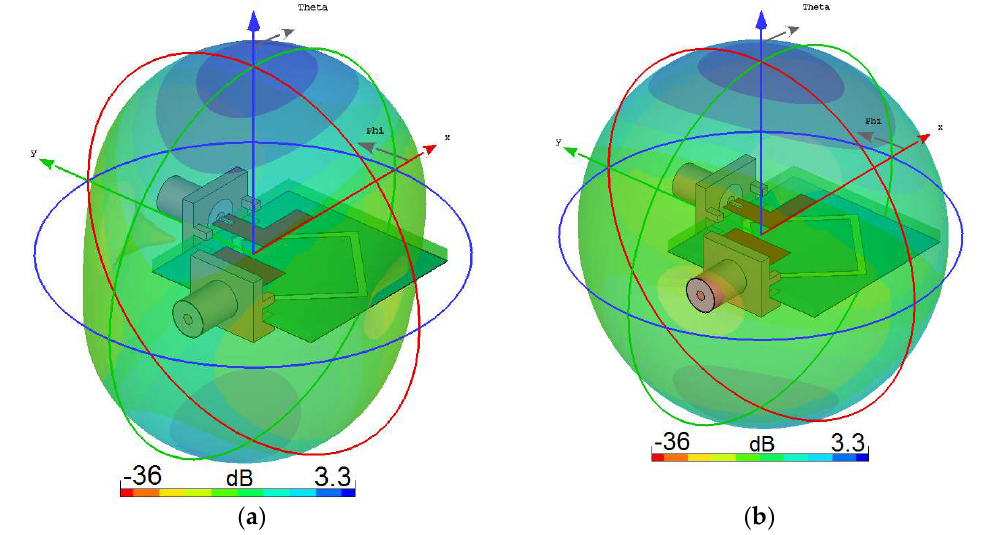
Figure 5. 3D views of the dual-polarized radiation patterns from ( a ) feeding port 1 and ( b ) feeding port 2.